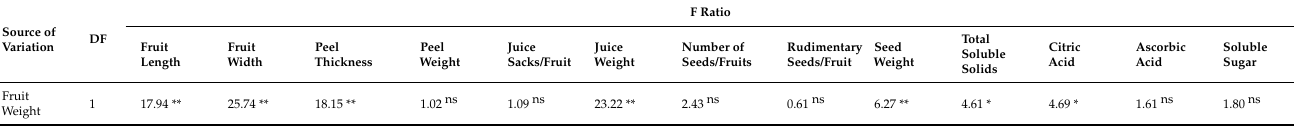
Table 4. MANOVA for fruit weight vs fruit morphology and nutritive properties of C. sinensis .